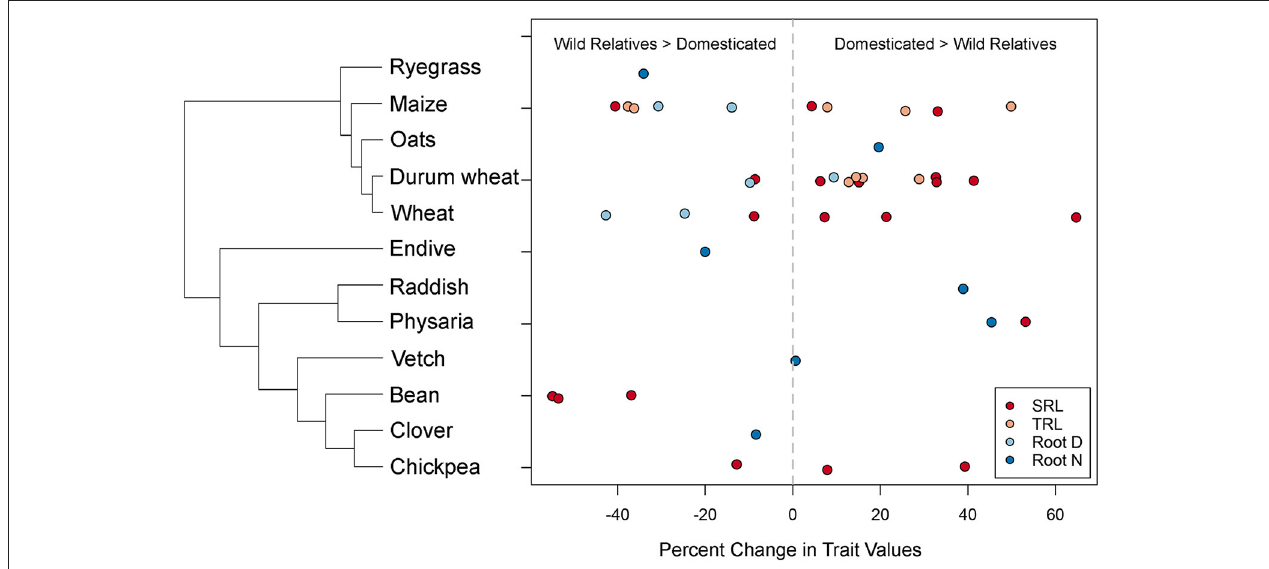
FIGURE 3 | Percent change in trait values for 12 crops, organized according to their phylogenic relationships, and their paired wild relatives. Specific root length (SRL), total root length (TRL), root diameter (root D), and root nitrogen (root N) are depicted.